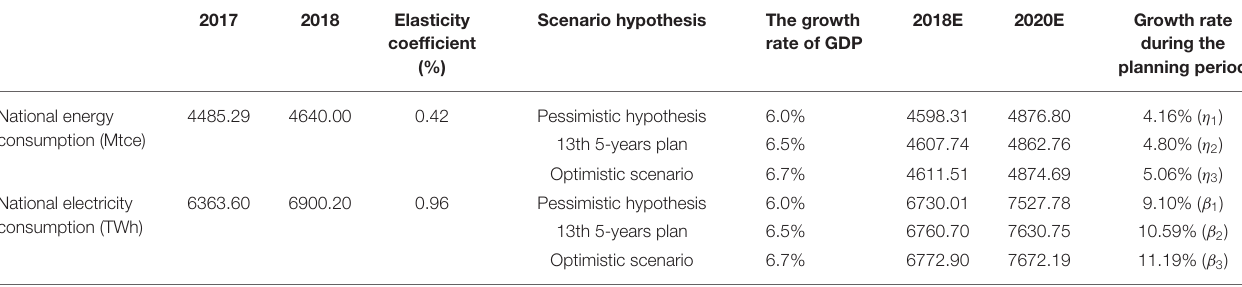
TABLE 1 | The growth rate of national energy consumption and electricity consumption under three scenarios.